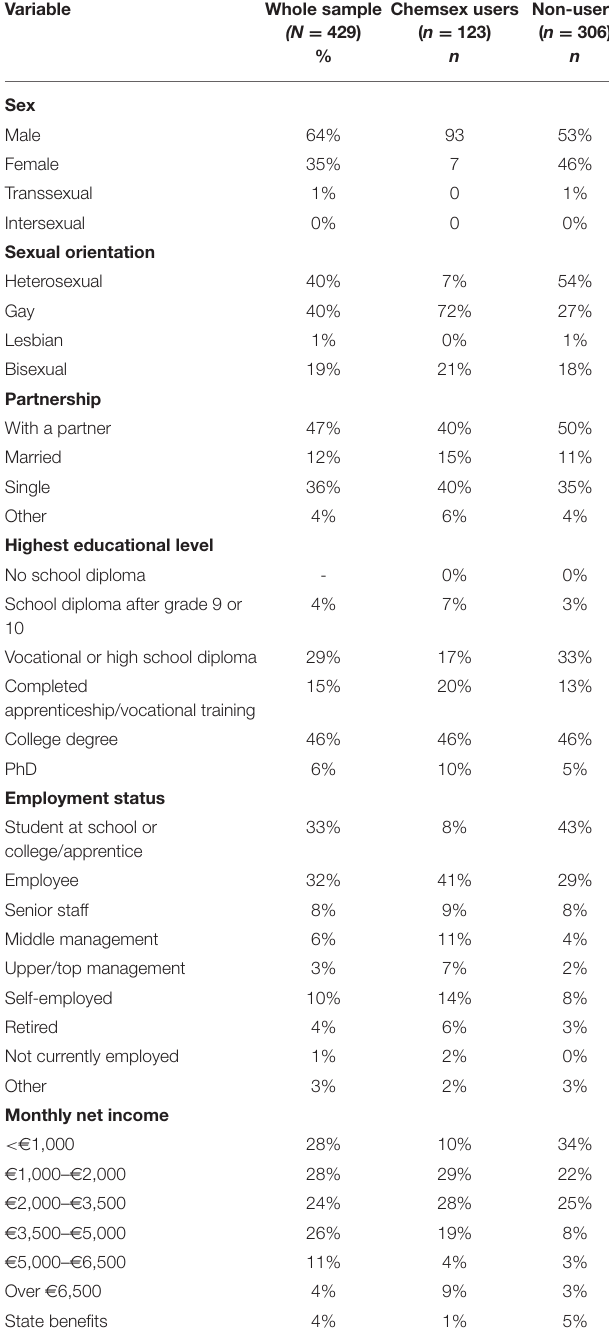
TABLE 2 | Sociodemographic characteristics of participants in an online survey of chemsex